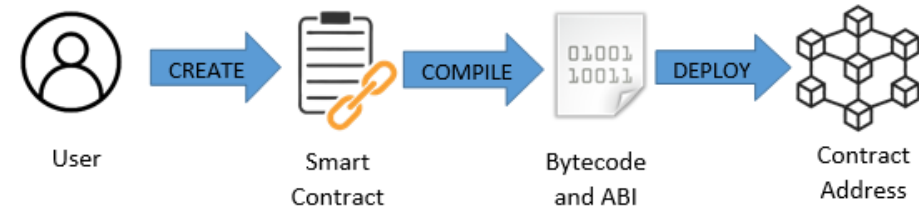
Figure 1. Contract compilation and